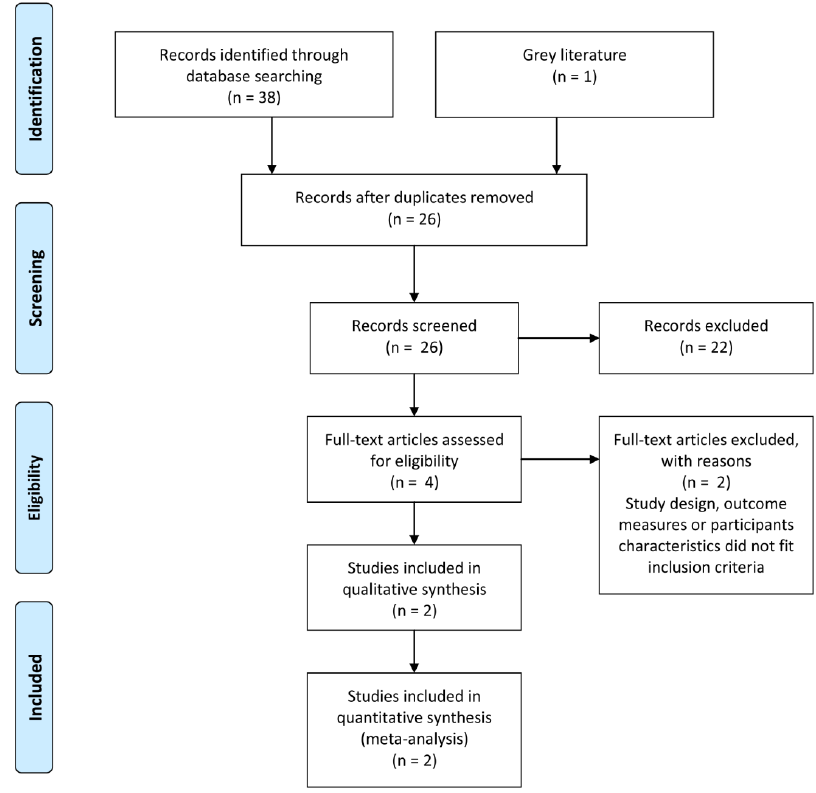
Figure 1. Flow diagram of the study. Table 2. Characteristics of the included